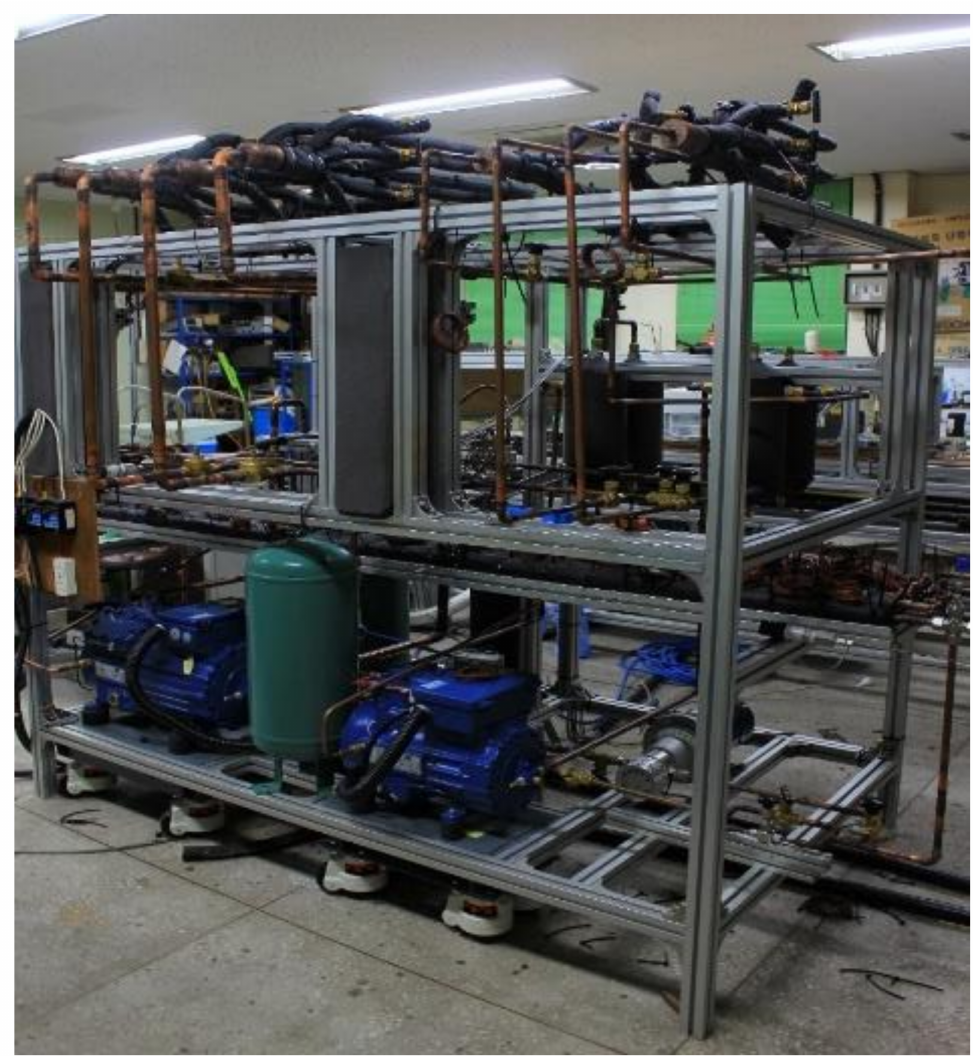
Figure 1. Photograph of the experimental apparatus for the CRS using